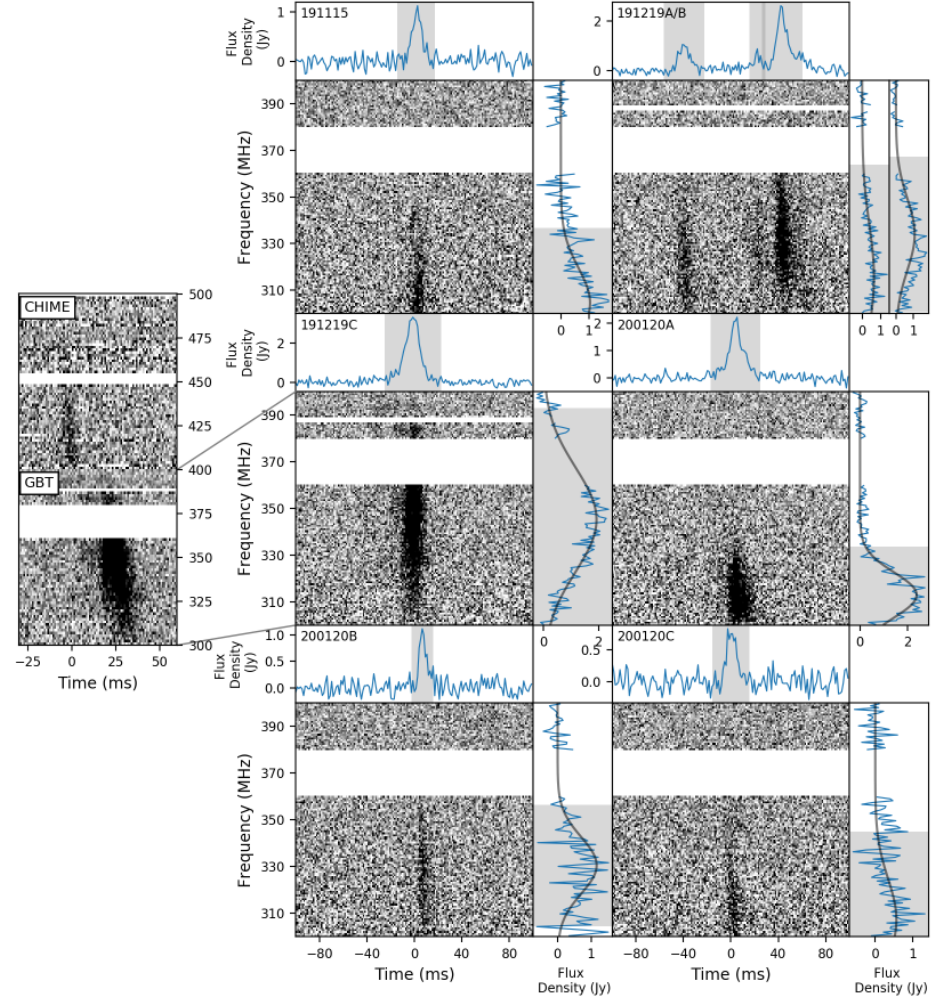
Figure 8. Figure 2 from [64] “Detection of Repeating FRB180916.J0158 + 65 Down to Frequencies of 300 MHz” reproduced with permission from Pragya Chawla, published by ApJL (IOP Publishing), 2020. It shows profiles, dynamic spectra and on-pulse spectrum for FRB20180916B’s bursts detected by GBT at 350 MHz. The inset shows the burst that was observed both in CHIME and GBT